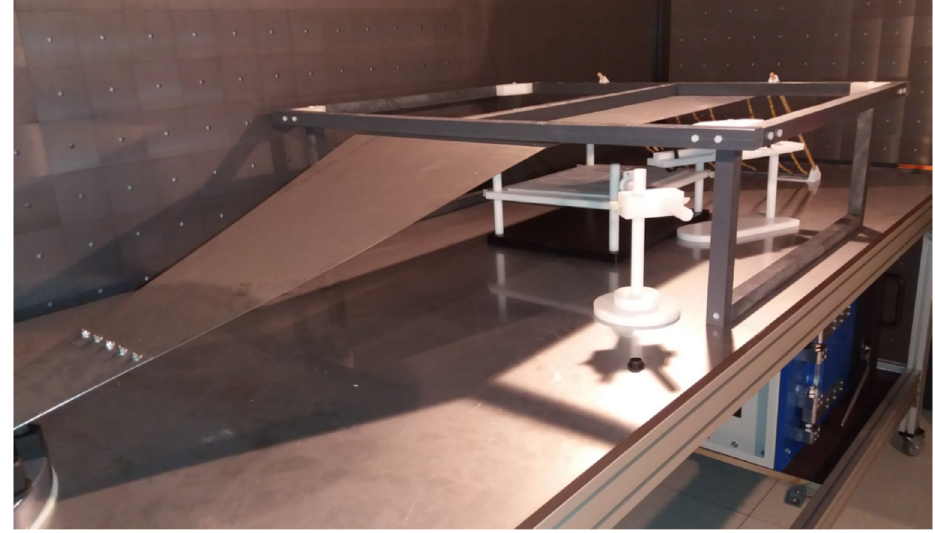
Figure 8. The working part of the stripline.